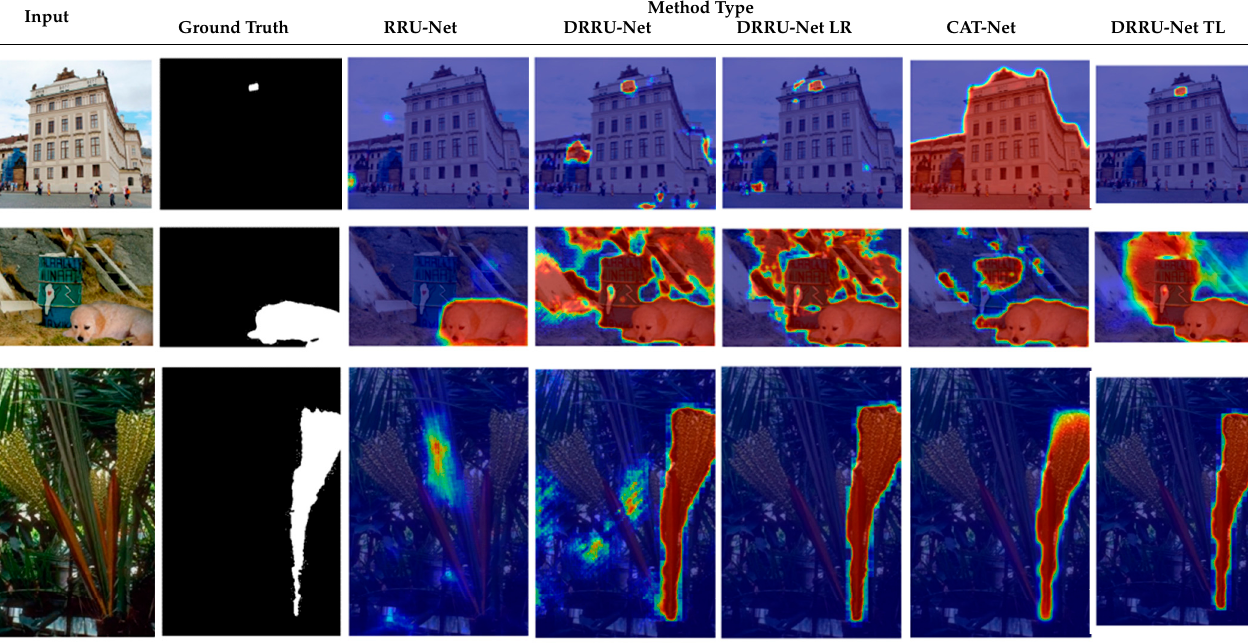
Table 5. Comparison of the prediction performance of forgery regions among all networks.